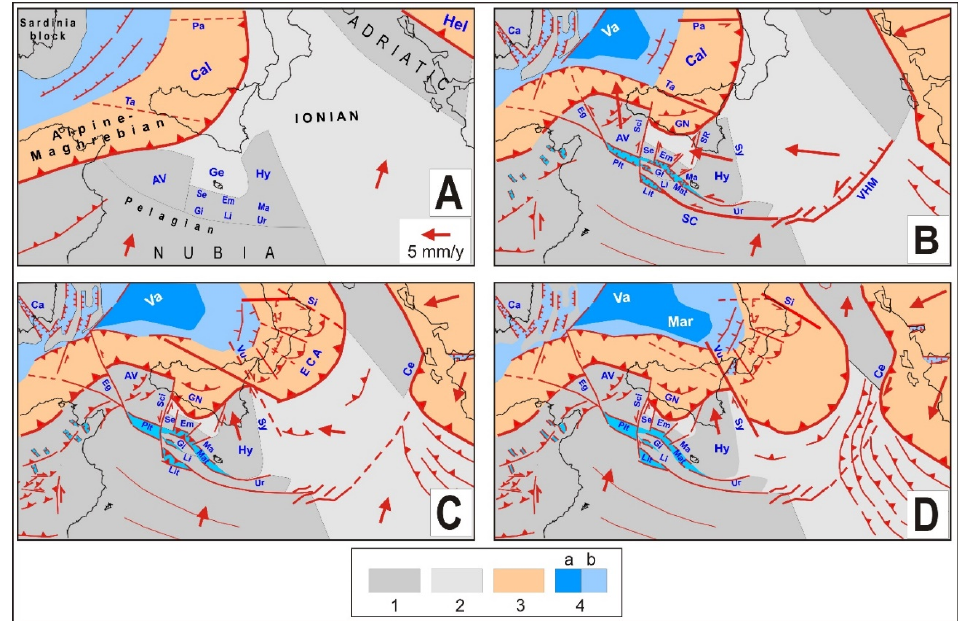
Figure 8. Tentative reconstruction of the tectonic processes that developed in the Hyblean–Adventure domain, in